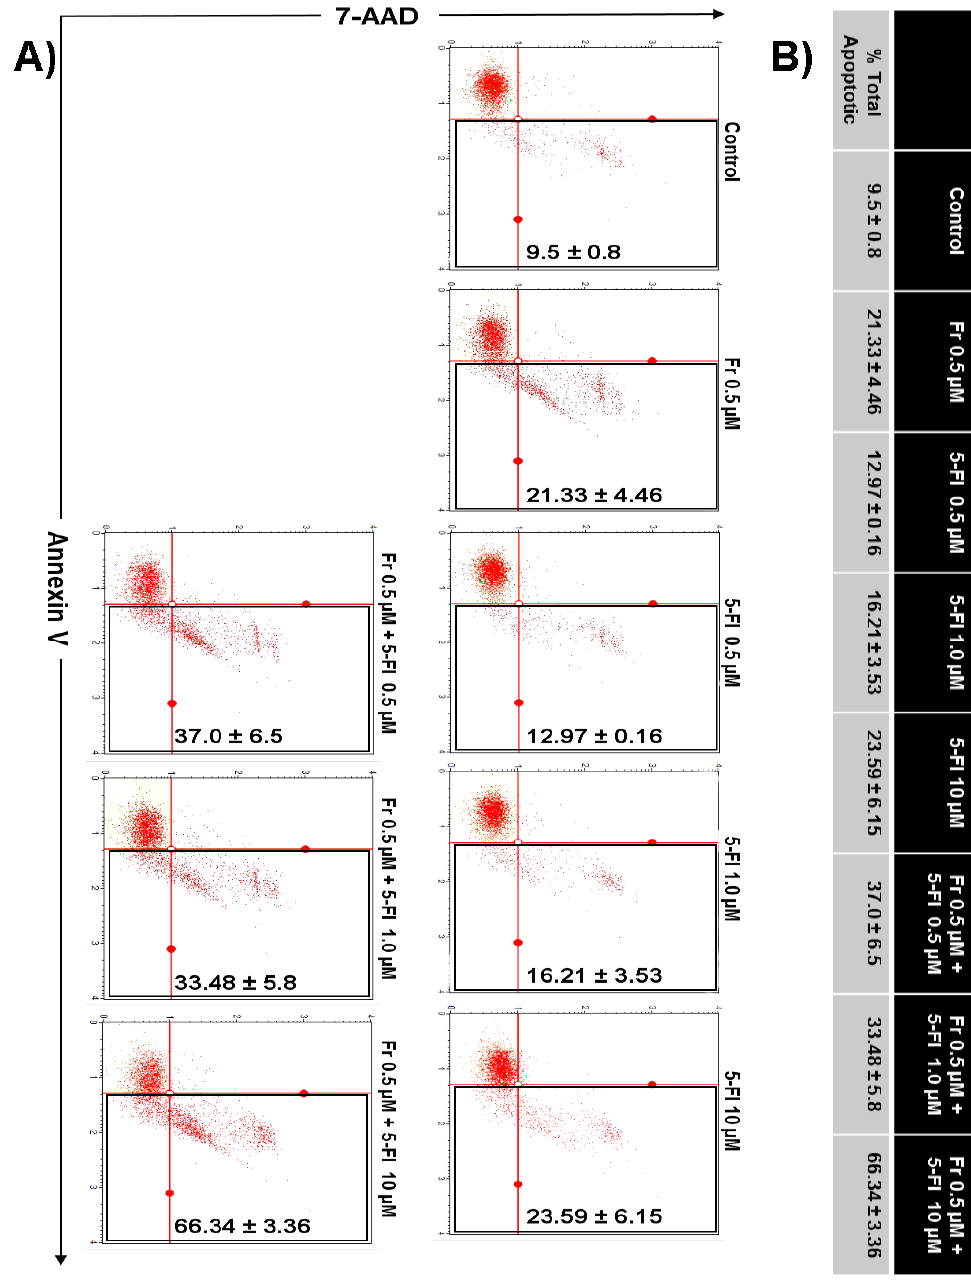
Figure 5. Frondoside A enhances apoptotic cell death induced by 5-fluorouracil in HT-29 colon